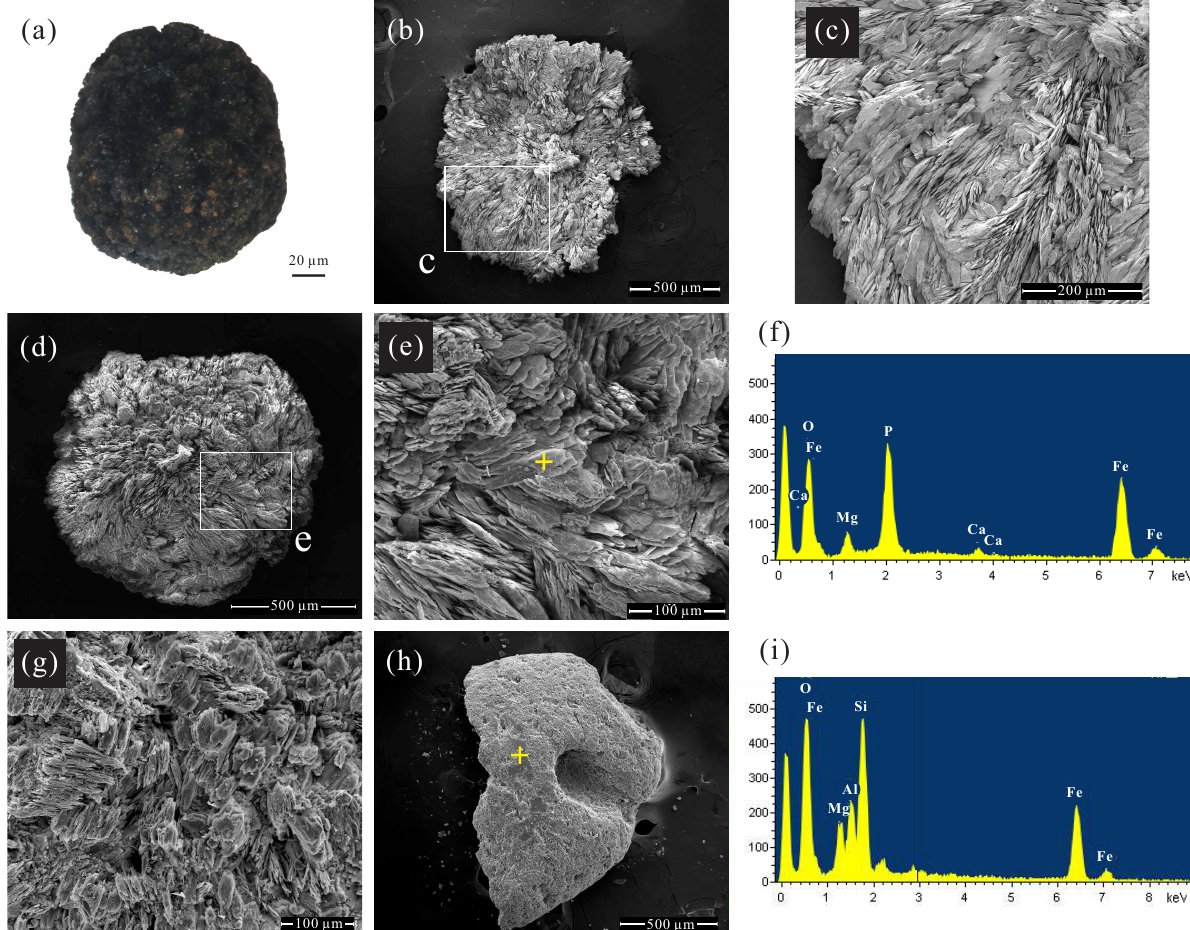
Figure 3. Images and chemical analyses of handpicked mineral aggregates from core 973-4. (a) Optical photomicrograph of an opaque dark mineral aggregate. (b–e, g) Scanning electron photomicrographs of the blue to black mineral aggregates found beneath the SMTZ. Samples (b) , (d) , and (g) were handpicked from sediments at 1087.5, 1093.5, and 973.5cm depth, respectively. The white boxes in (b) and (d) correspond to the fields of view enlarged in (c) and (e) , respectively. (f) A spot-measurement EDS spectrum corresponding to the yellow cross in (e) . (h) Scanning electron photomicrograph of the grey to green mineral aggregates from sediments at 602.5cm depth. (i) A spot-measurement EDS spectrum corresponding to the yellow cross in (h)